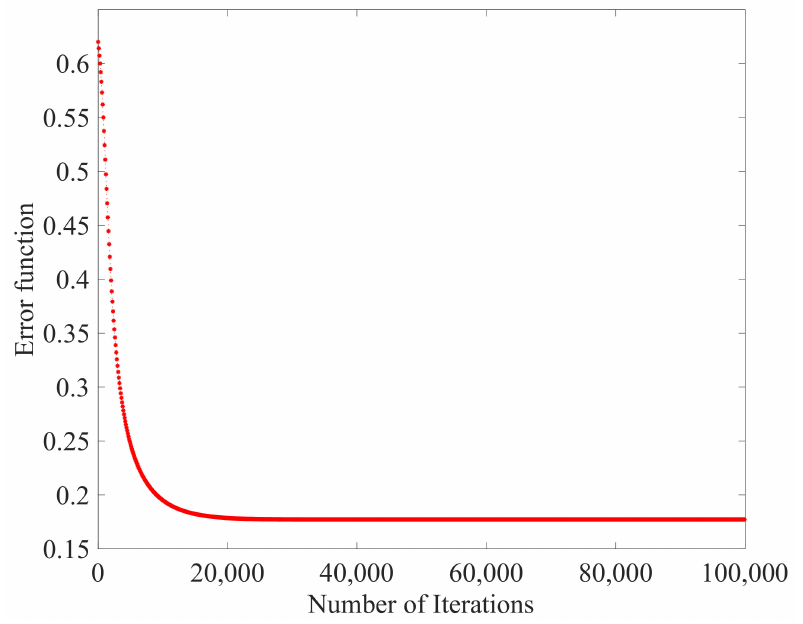
Figure 5. Error function as a function of the number of